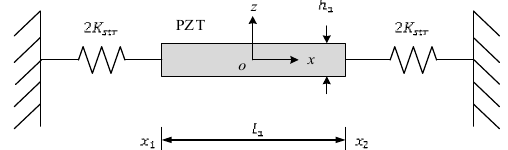
Figure 1. Simplified piezoelectric electro-mechanical impedance (EMI) Model.